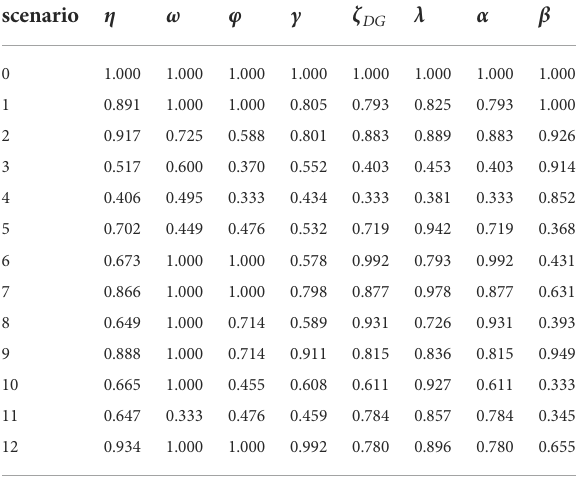
TABLE 8 Correlation coef fi cient of each situation assessment index under different cyberattack scenarios. scenario η